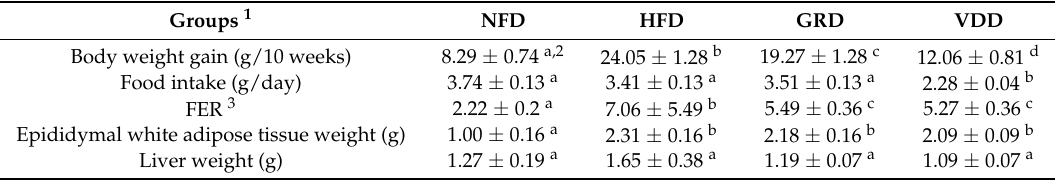
Figure 2. Effects of Valeriana dageletiana Nakai ex F. Maek. extract from the above-ground part (VDAE) on body weight ( A ) and food intake ( B ) in high-fat diet-induced obese mice. Results are presented as means ± SE ( n = 6). NFD; normal fat diet control, HFD; high fat diet control, GRD; HFD + 1% Garcina cambogia extract, VDD; HFD + 1% Valeriana dageletiana Nakai ex F. Maek extract from above-ground part. Table 3. Effects of Valeriana dageletiana Nakai ex F. Maek extract from the above-ground part (VDAE) on body weight in mice fed a high-fat diet.